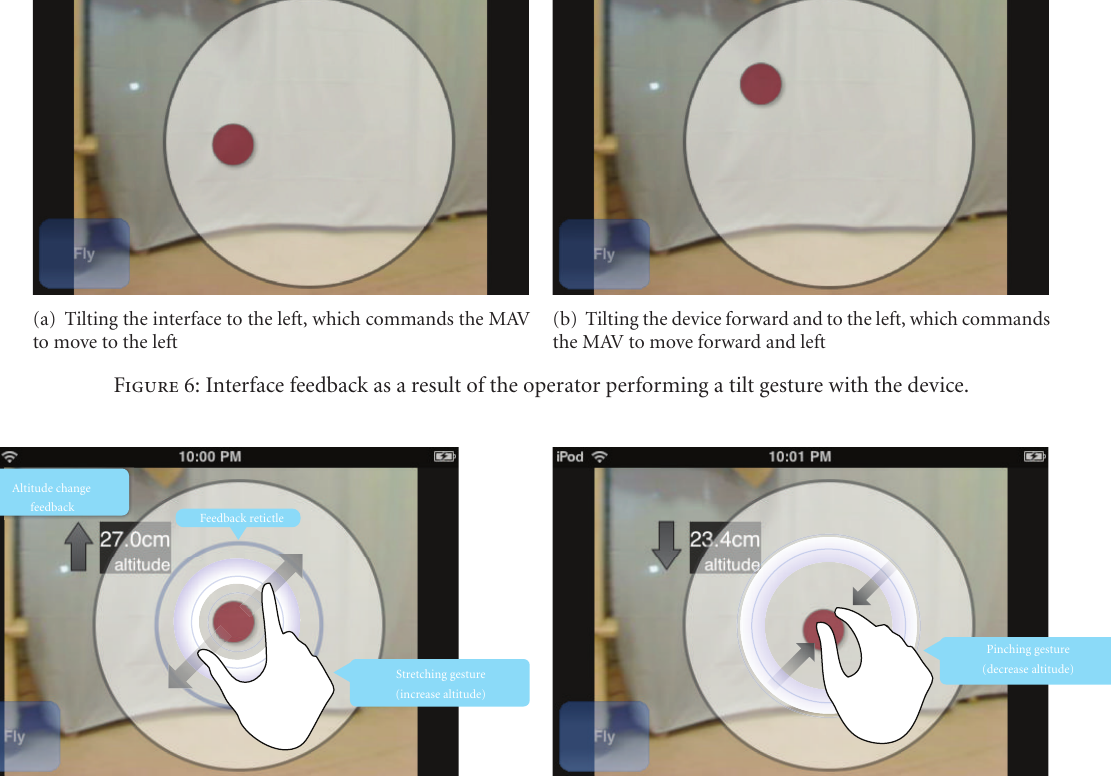
Figure 7: Gestures to change the z coordinate (altitude) of the